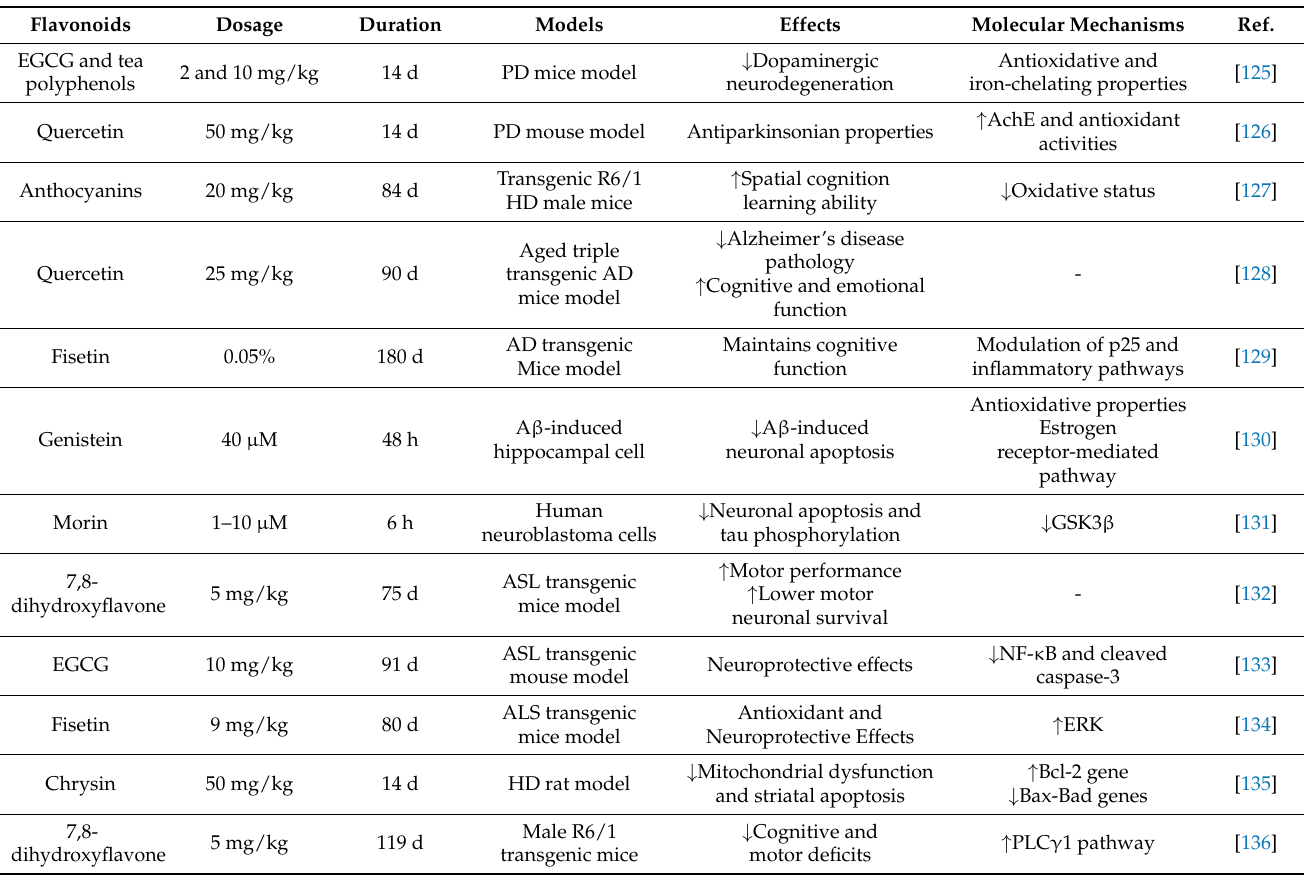
Table 3. Neuro-protective roles of flavonoids in experimental